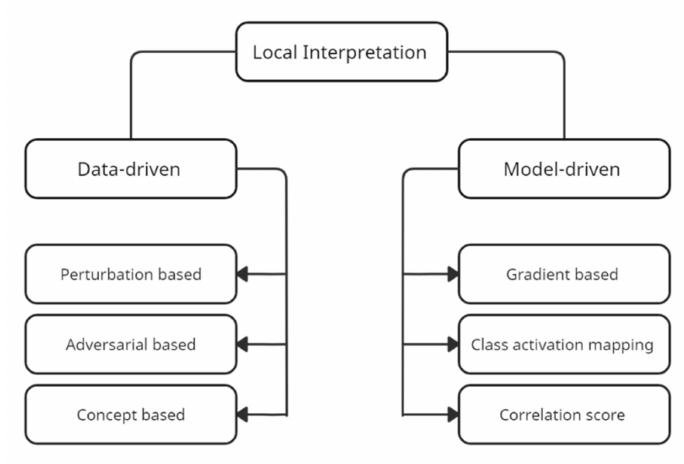
Figure 2. Classification of ML interpretation methods.